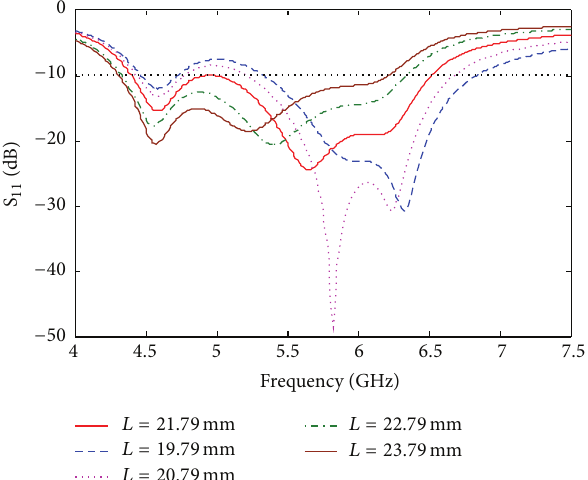
Figure 3: Frequency behavior of the magnitude of the reflection coefficients as a function of the length 𝐿 with 𝑊 = 2.35 mm, 𝑃 𝑥 = 3.85 mm, 𝑅 = 15.29 mm, 𝑅 = 20.22 mm, 𝑅 = 8.70 mm, and 𝑅 = 10.09 in 1 out 1 in 2 out 2